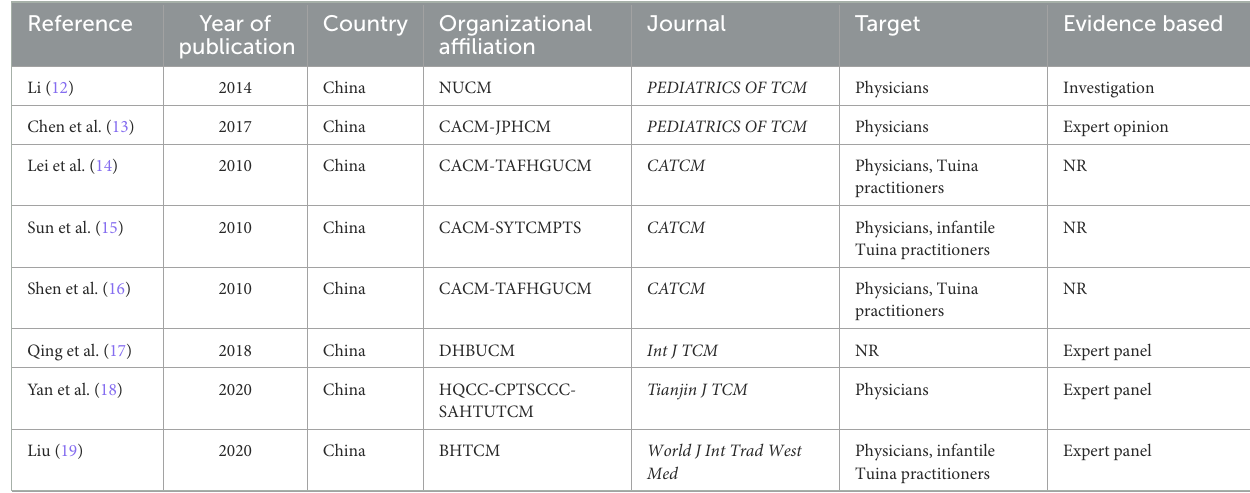
TABLE 1 Characteristics of the included